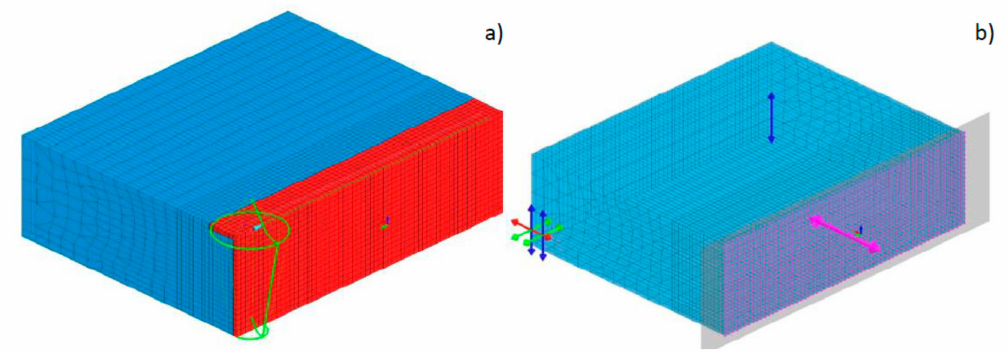
Figure 11. View ( a ) of the symmetrical three-dimensional model of the laser bead-on-plate welding process together with a conical model of the heat source and the “LOAD” area, and ( b ) boundary clamping